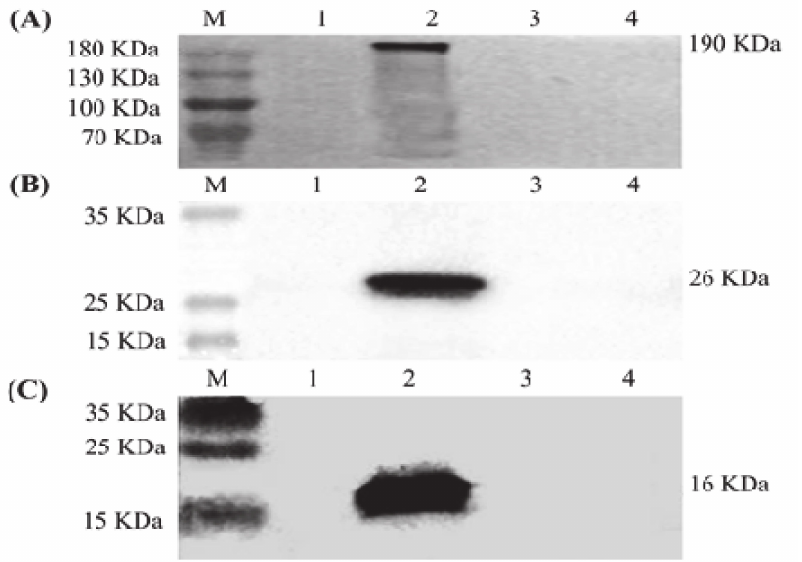
Figure 2. Identification of the recombinant proteins’ expression using Western blotting. ( A ) The S protein expressed by recombinant baculovirus rHBM-S. ( B ) The M protein expressed by recombinant baculovirus rHBM-M. ( C ) The E protein expressed by recombinant baculovirus rHBM-E. Lane M, protein molecular weight marker; Lane 1, culture supernatant; Lane 2, cell lysate; Lane 3, wild-type baculovirus; Lane 4, Sf9 cells.